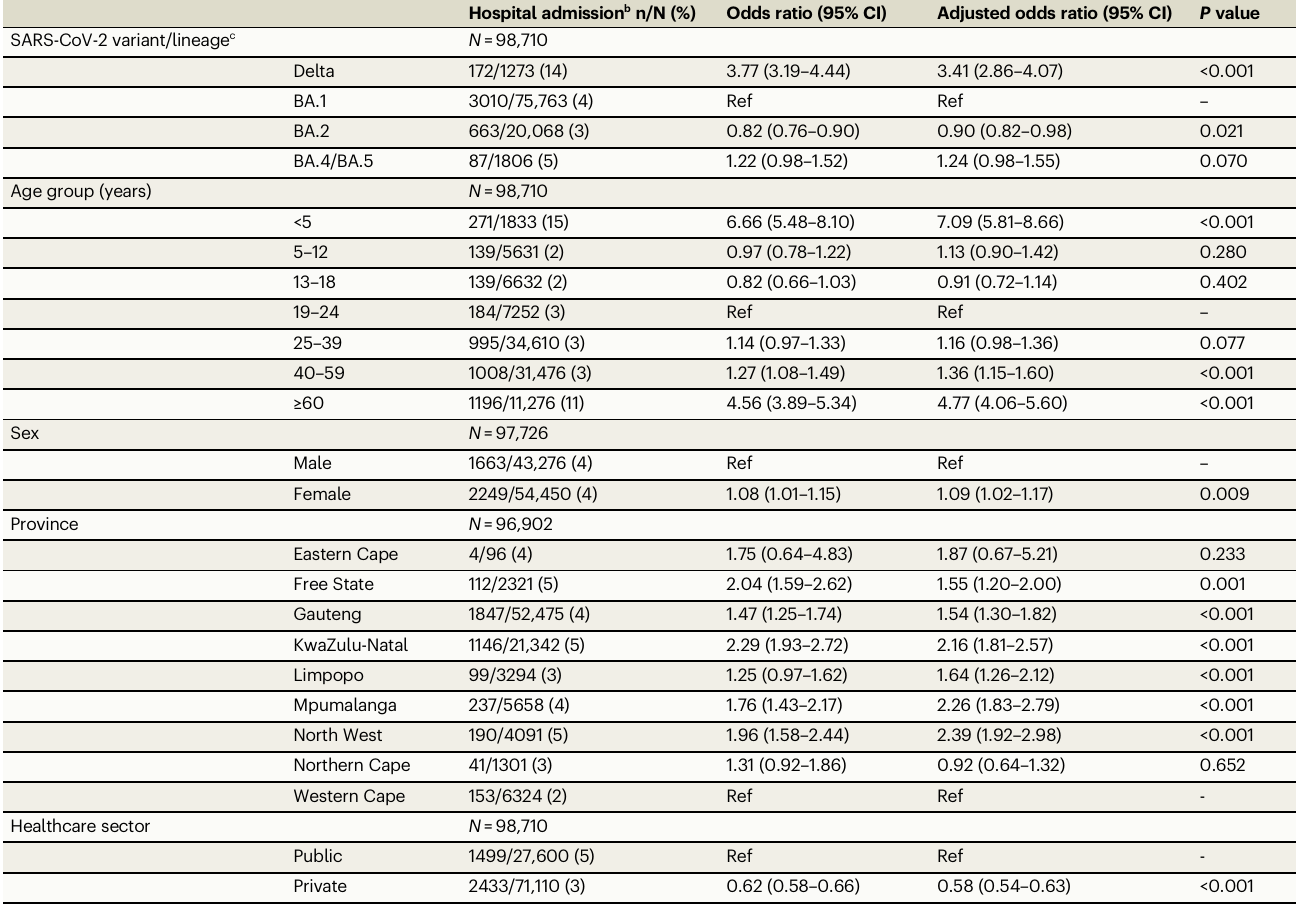
Table 2 | Multivariable logistic regression analysis evaluating the association between SARS-CoV-2 variant/lineage and hos- pitalisation, South Africa, 1 October 2021 – 26 April 2022 a ( N =